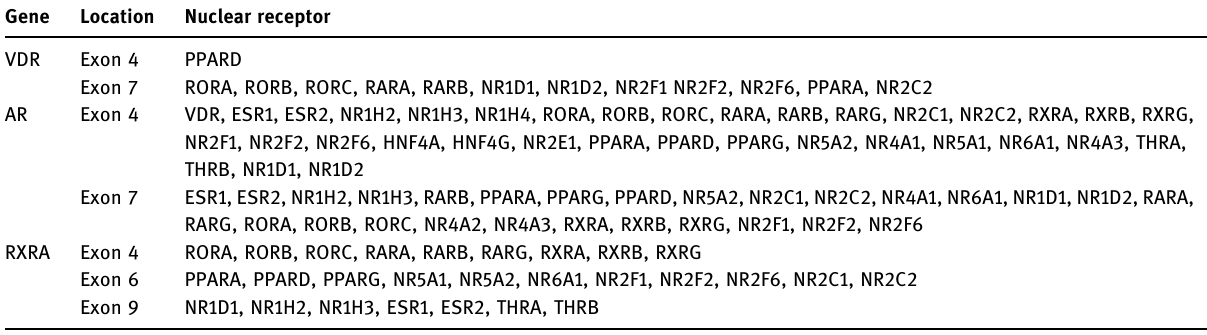
Table 3: Nuclear receptor - binding domains detected in the exonic conserved sequences of three NR genes involved in prostate cancer etiology Gene